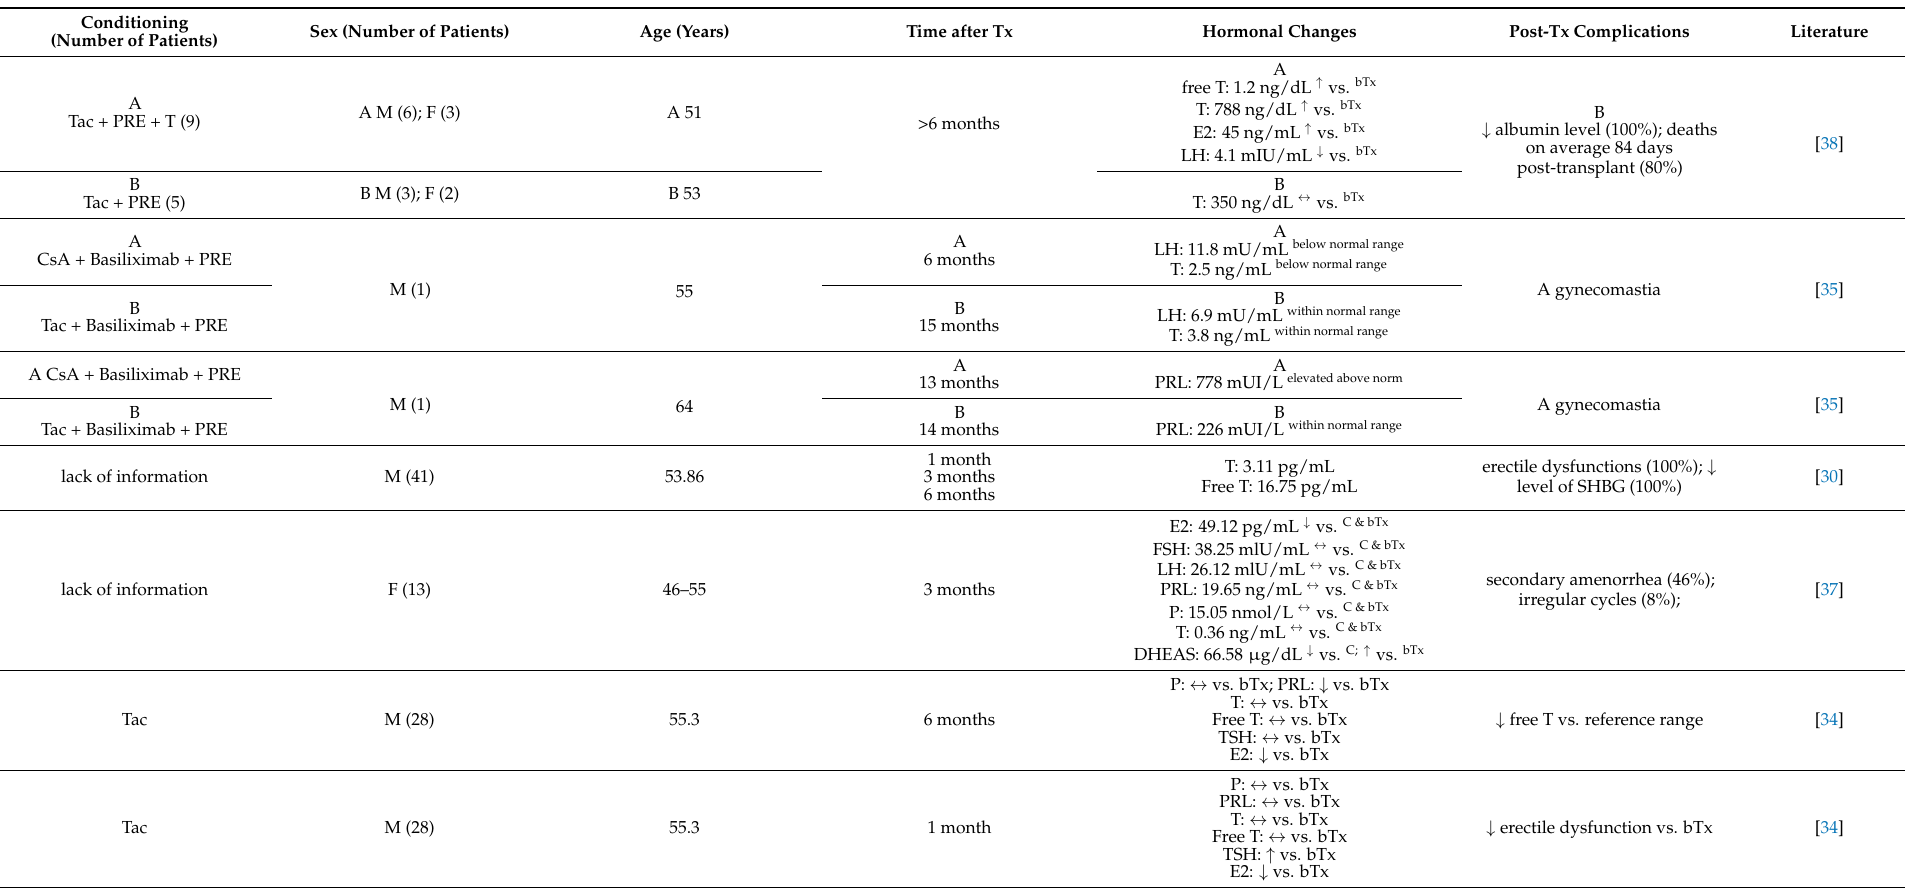
Table 2. Demographical and medical data of liver transplant